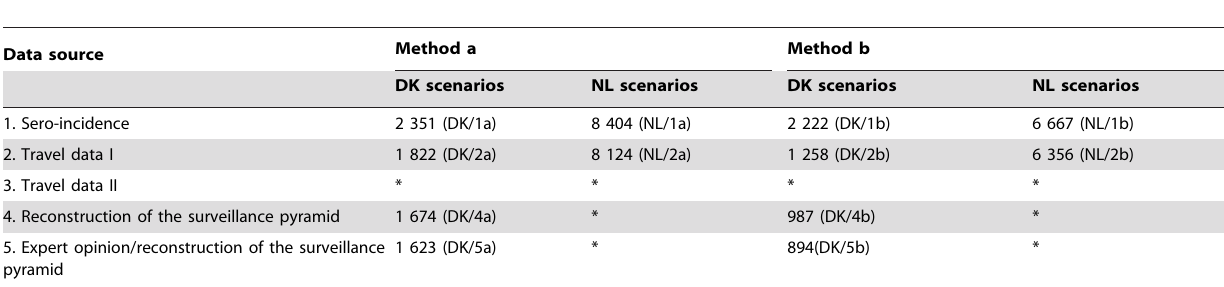
Table 3. Expected increase in the number of reported domestic salmonella cases in Sweden in 2010, if the Swedish salmonella control had been substituted with a programme similar to the Danish (DK) or the Dutch (NL) control